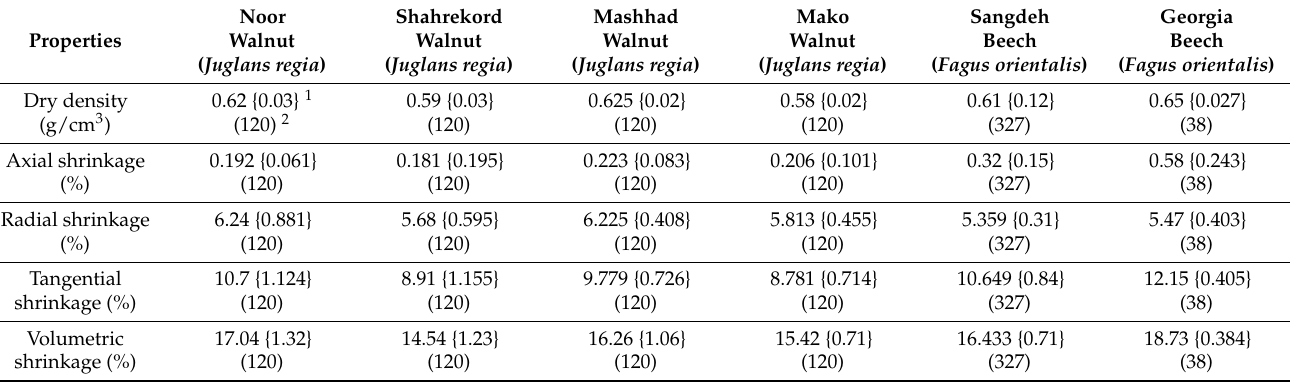
Table 3. Physical properties of the studied wood species.